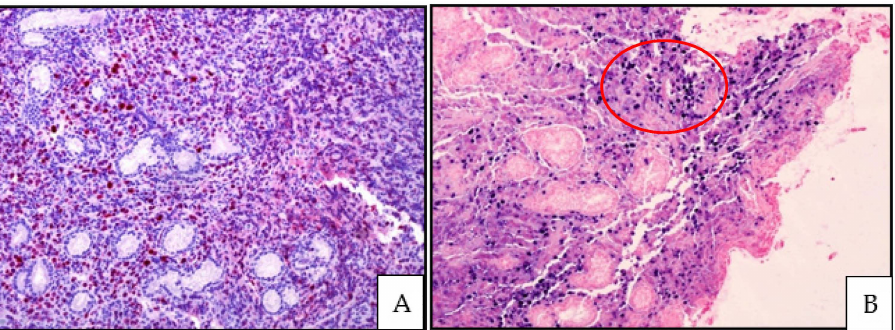
Figure 2. ( A ) EBV-positive DLBCL, NOS: Ki67 immunostaining revealing an elevated proliferative index of the lymphoid infiltrate (magnification 200 × ; original image from Prof S.A.); ( B ) EBV-positive DLBCL, NOS: EBER showing positive signals for EBV in the nuclei of the lymphoid infiltrate (inside the red circle) (magnification 200 × ; original image from Prof